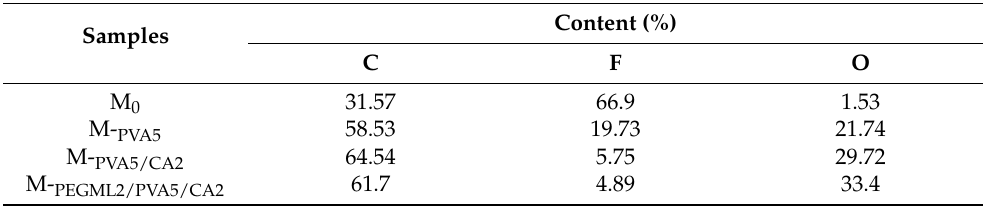
Figure 5. XPS spectra of different PTFE microfiltration membranes ( a ) and C1s XPS spectra of M 0 ( b ), M ‐ PVA5 ( c ), M ‐ PVA5/CA2 ( d ), and M ‐ PEGML2/PVA5/CA2 ( e ) . Table 3. Surface element composition of different PTFE microfiltration